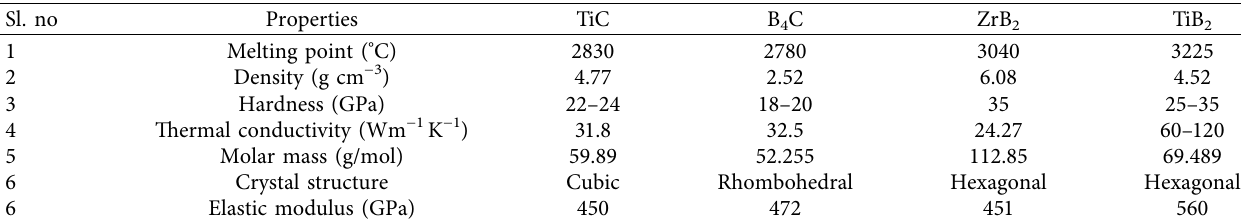
Figure 6: Influence of various parameters on hardness. Table 1: Physical and mechanical properties of several ceramics